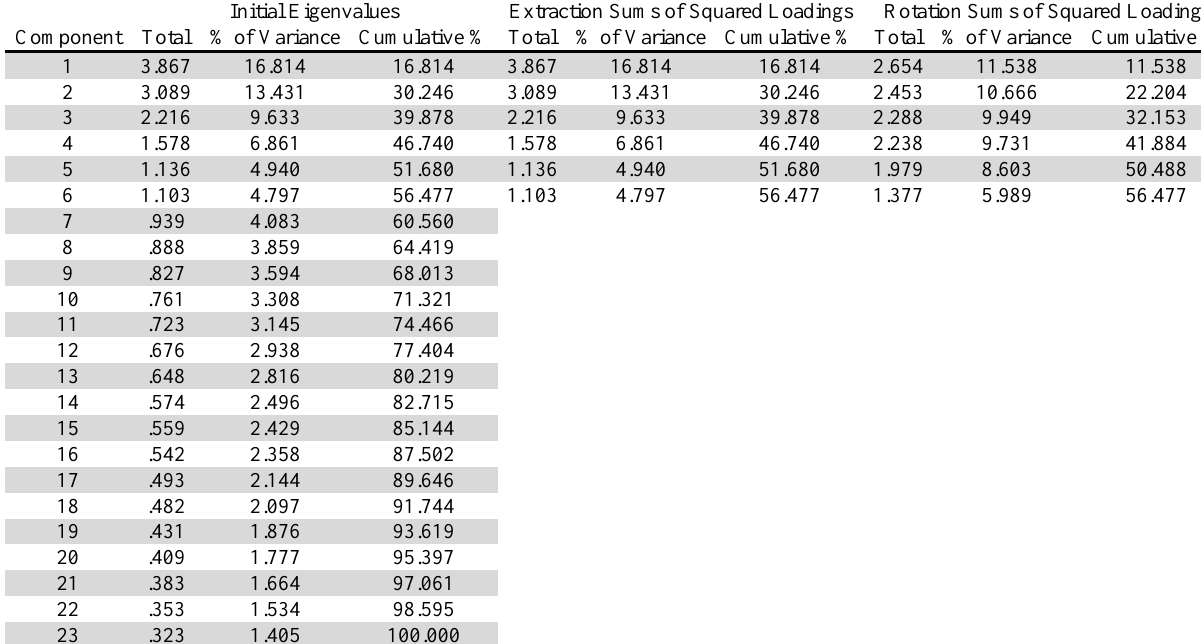
Extraction Sums of Squared